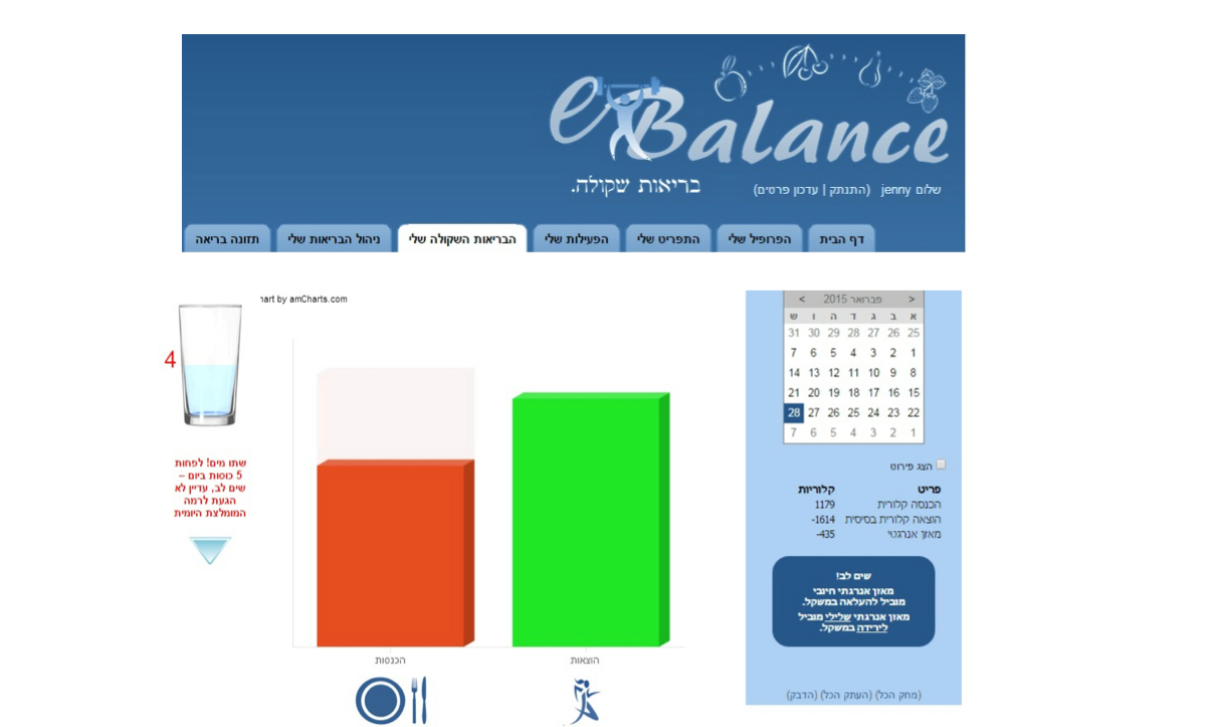
Figure 1. Screenshot of the eBalance Web-based